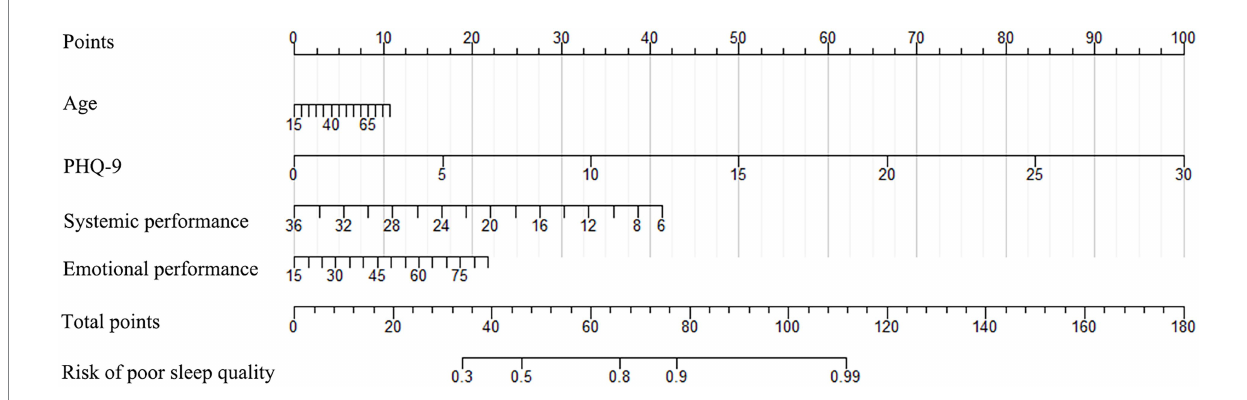
FIGURE 2 The nomogram used to predict poor sleep quality in IBD patients (PHQ-9, Patient Health